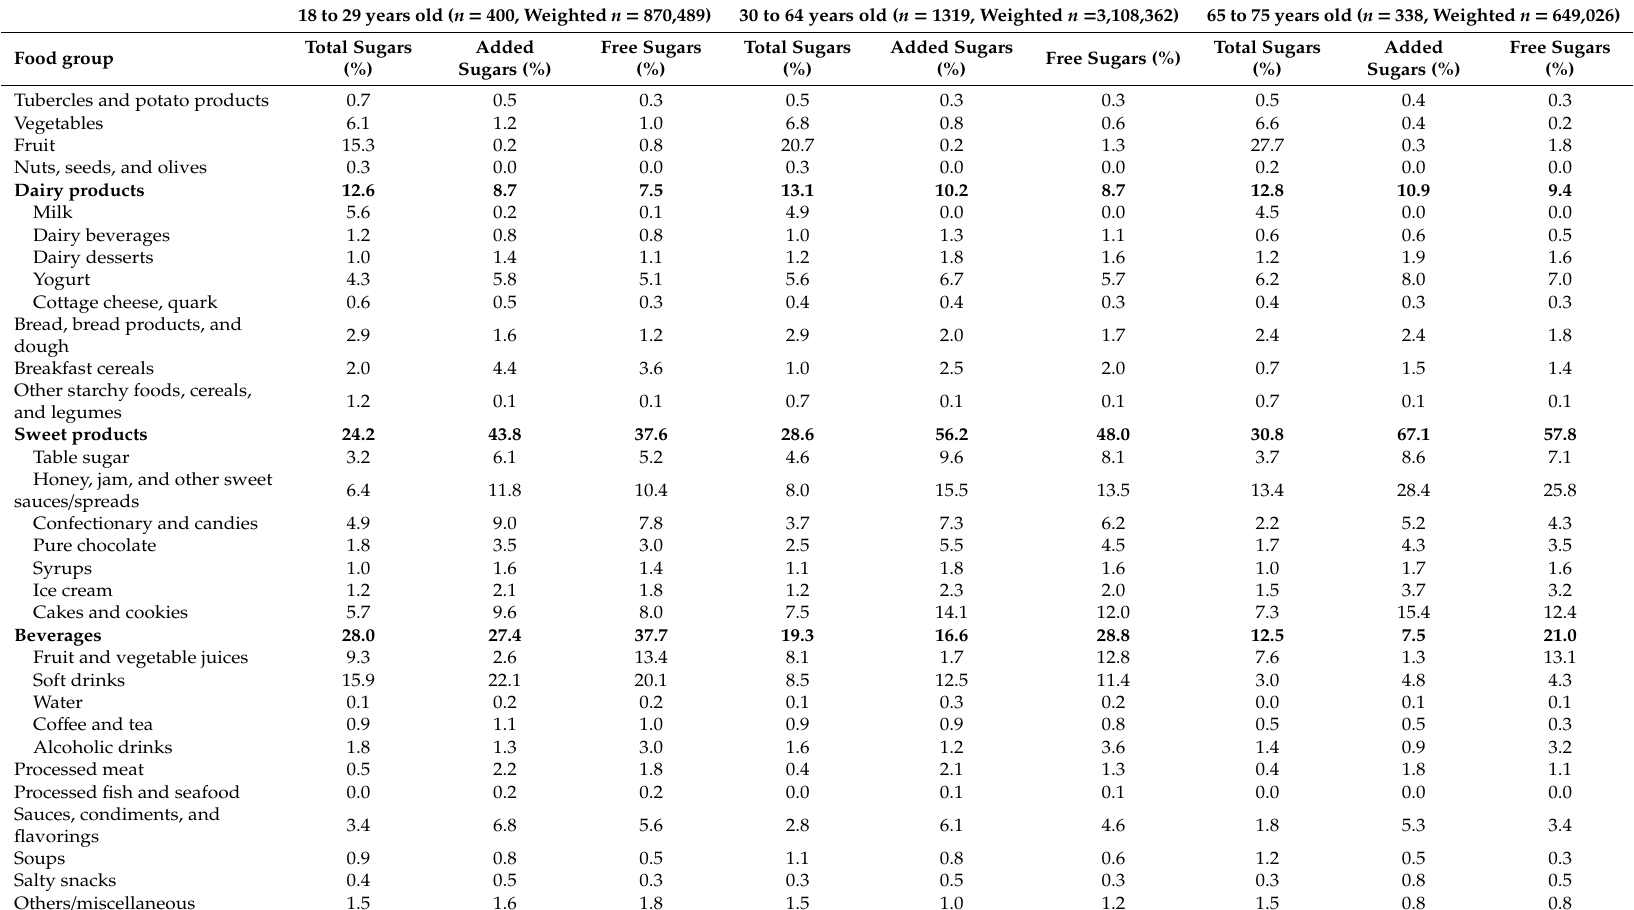
Table 3. Mean contribution by food group for total, added, and free sugars by age